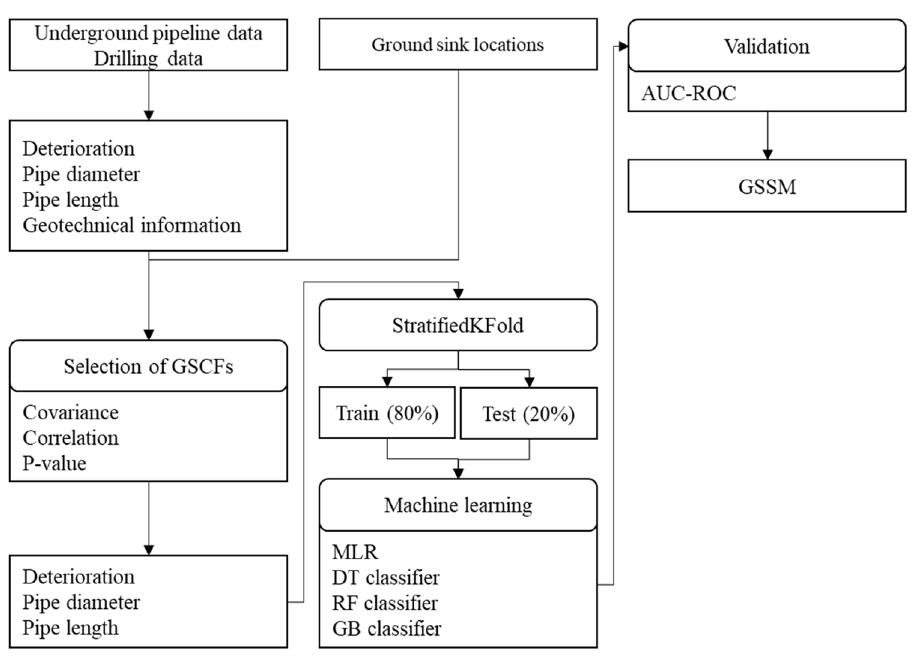
Figure 4. Flow chart of